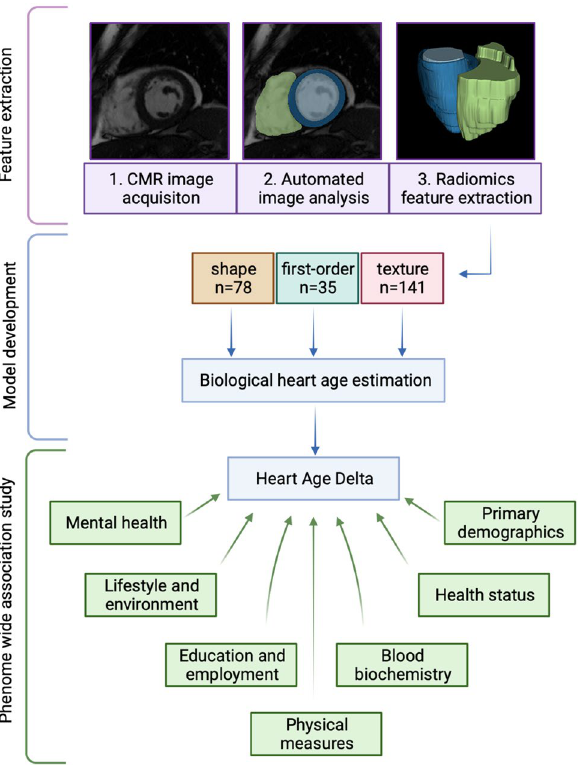
Figure 1. Summary of study